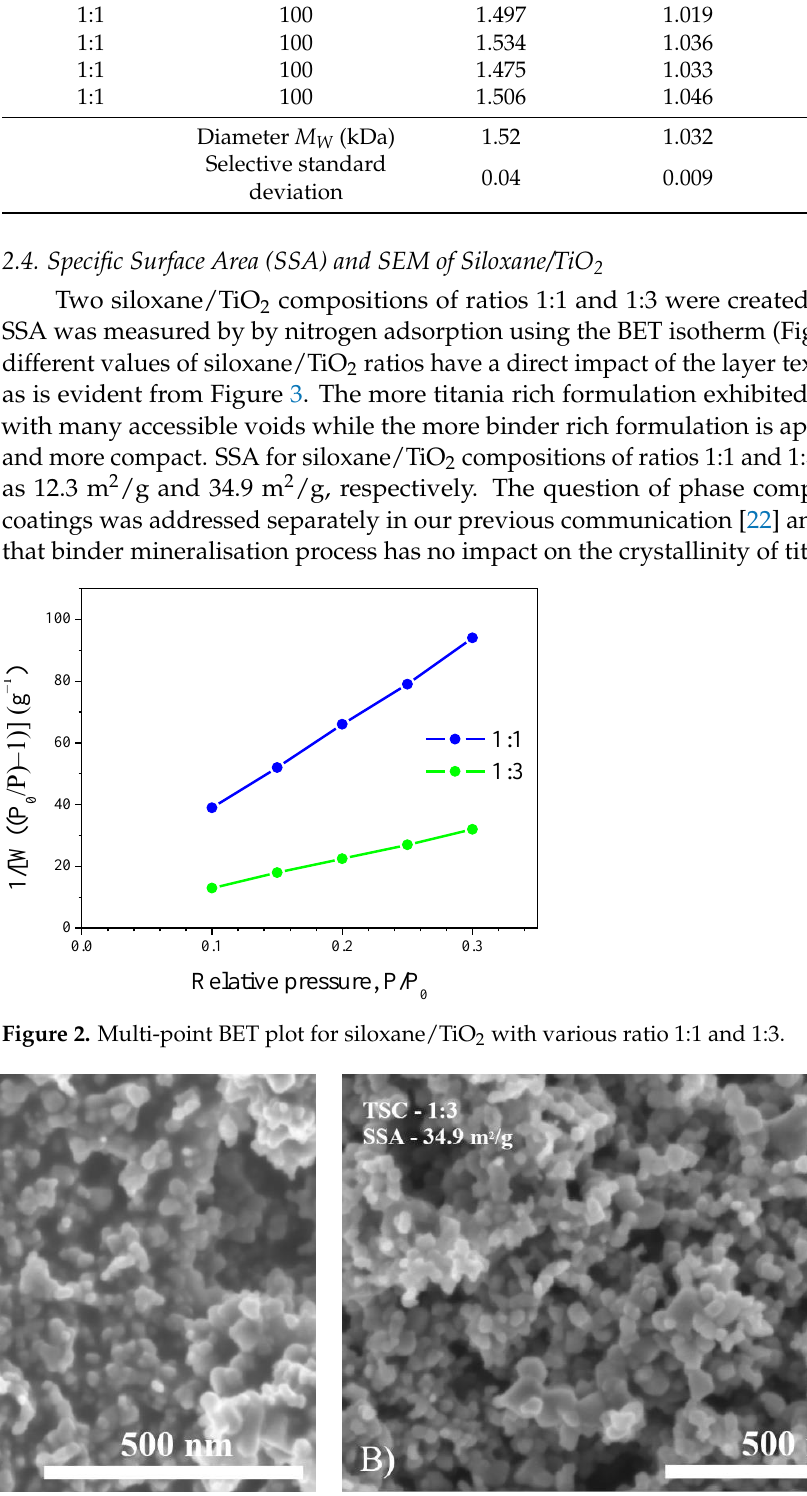
Figure 3. SEM images. ( A ) Shows a less porous layer with a siloxane/TiO 2 ratio of 1:1, and ( B ) shows a much more porous layer of a 1:3 ratio.